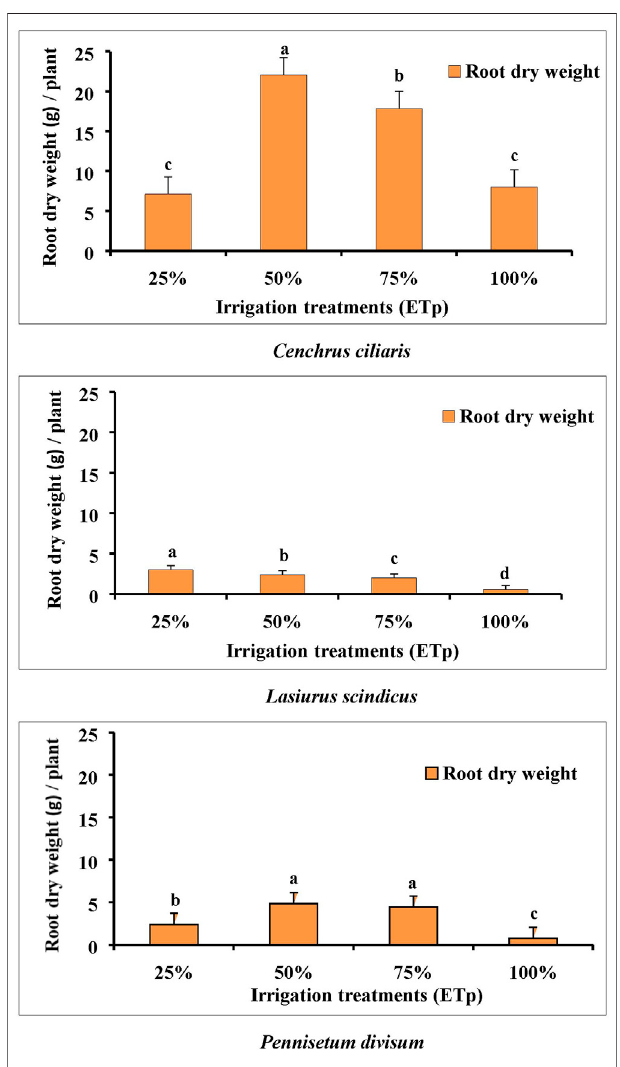
FIGURE 5 | Effect of different irrigation regimes on mean root dry weight measurement of Cenchrus ciliaris , Lasiurus scindicus , and Pennisetum divisum . Bars labeled with different letters present signi fi cant difference at p < 0.001 and p < 0.05 between treatments. d. f = 16.